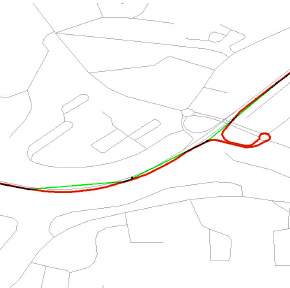
Figure 1 Probe vehicle and its true path and road